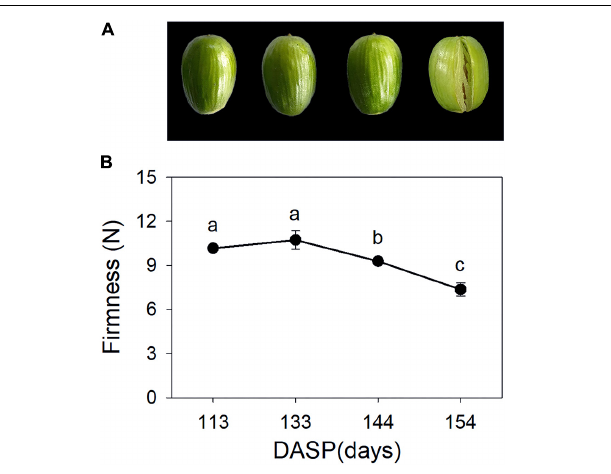
FIGURE 1 | Changes in aril appearance and firmness in Torreya grandis during nut maturation. (A) Appearance of whole nuts; (B) aril firmness. Error bars represent standard error base on three biological replicates. Different lowercase letters within a row indicate a significant difference at different growth stages by Duncan’s multiple range test ( P < 0.05). N =